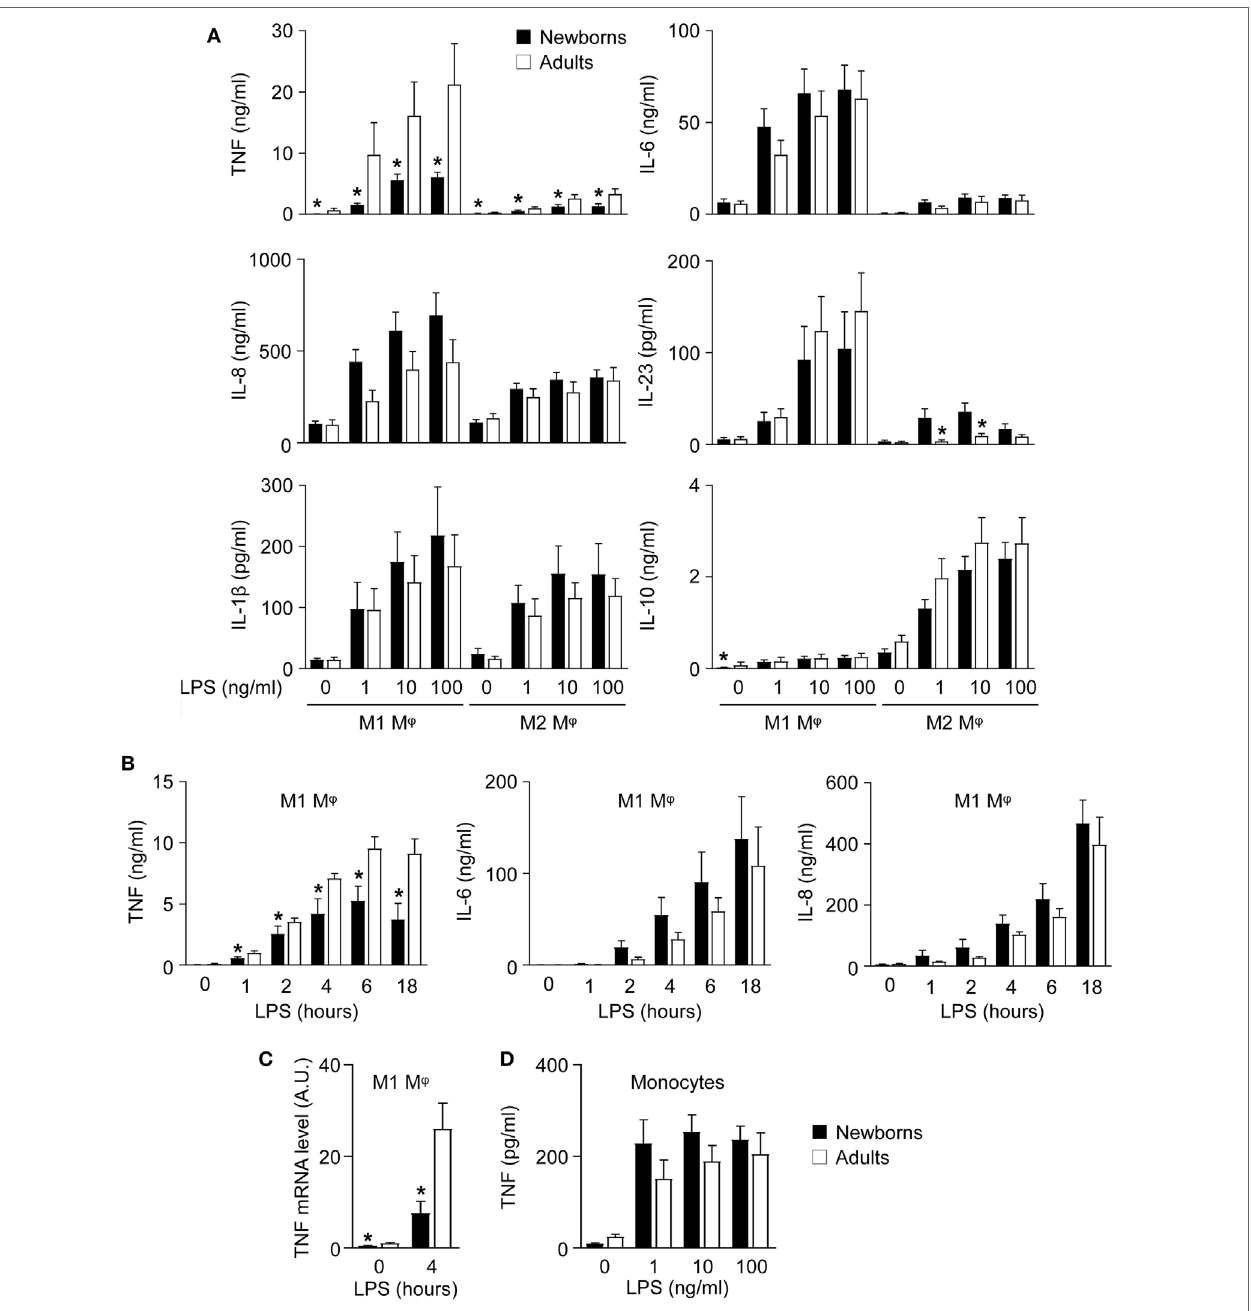
FigUre 2 | Newborn M1 macrophages secrete reduced amounts of TNF after lipopolysaccharide (LPS) stimulation. Newborn (black bars) and adult (white bars) monocytes were cultured for 7 days with GM-CSF (50 ng/ml) and with M-CSF (50 ng/ml) to induce M1 (a–c) and M2 macrophages (a) . Macrophages (a–c) and monocytes (D) were stimulated with 0–100 ng/ml LPS. (a) Cytokine levels were measured in cell culture supernatants collected after 20 h. Data are means ± SEM from 20 (TNF, IL-6, IL-8, IL-1 β , and IL-10) or 10 (IL-23) newborn and adult subjects. (B) TNF, IL-6, and IL-8 levels were measured in cell culture supernatants collected after 0–18 h. Data are means ± SEM from eight newborns and six adults. (c) TNF mRNA expression levels in M1 macrophages exposed for 0 and 4 h to 100 ng/ml LPS were measured by RT-PCR. Data are means ± SEM from 10 newborns and 9 adults. (D) TNF concentrations in cell culture supernatants of monocytes exposed for 20 h to 0–100 ng/ml LPS. Data are means ± SEM from 20 newborns and 10 adults. * P <